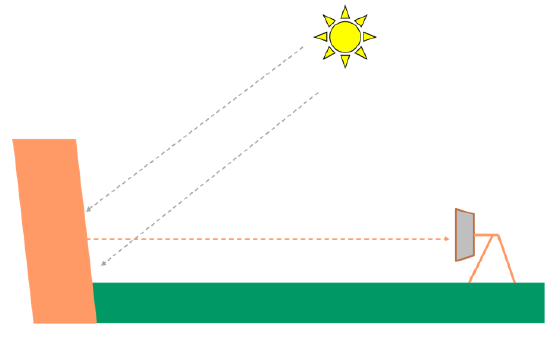
Figure 1. Horizontal scan geometry.